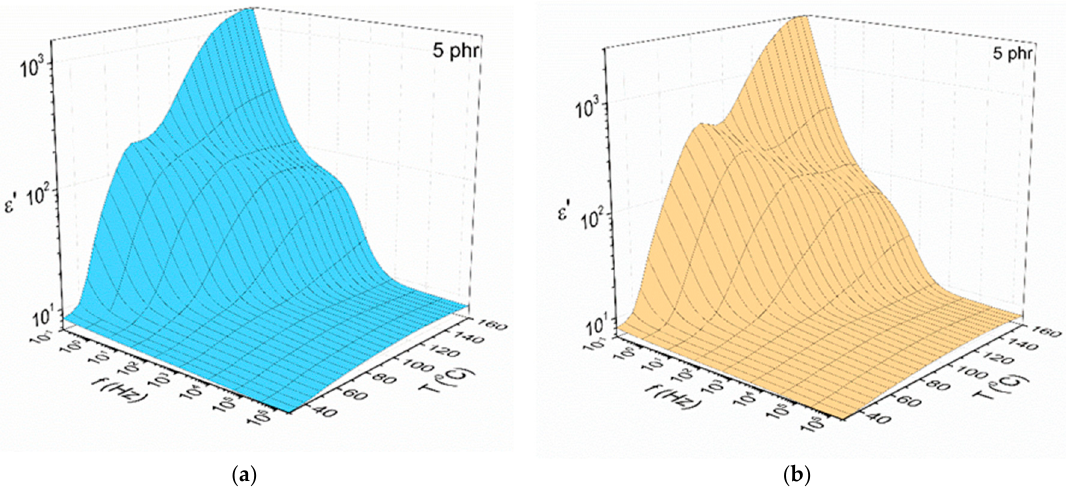
Figure 3. The variation of the real part of dielectric permittivity as a function of frequency and temperature for the nanocomposites with 5 phr: ( a ) BaFe 12 O 19 ; ( b ) SrFe 12 O 19 filler